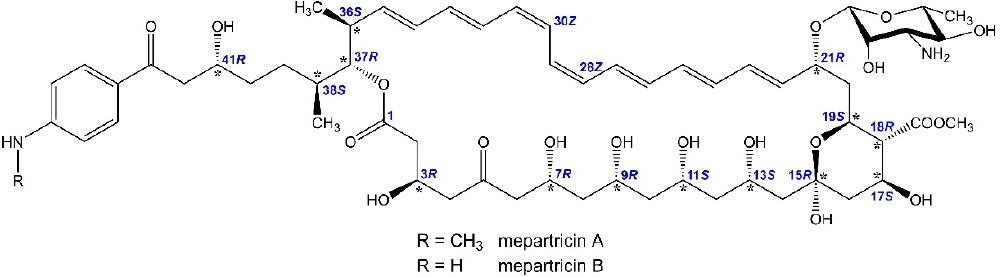
Figure 1. Stereochemistry of mepartricin A and B.